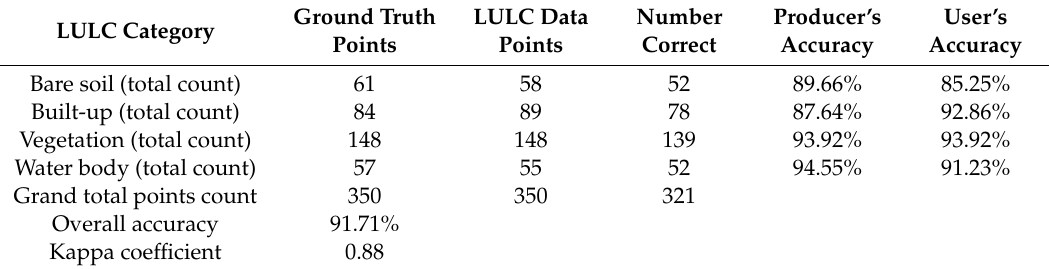
Table 4. The error matrix for the classified image of 2009.